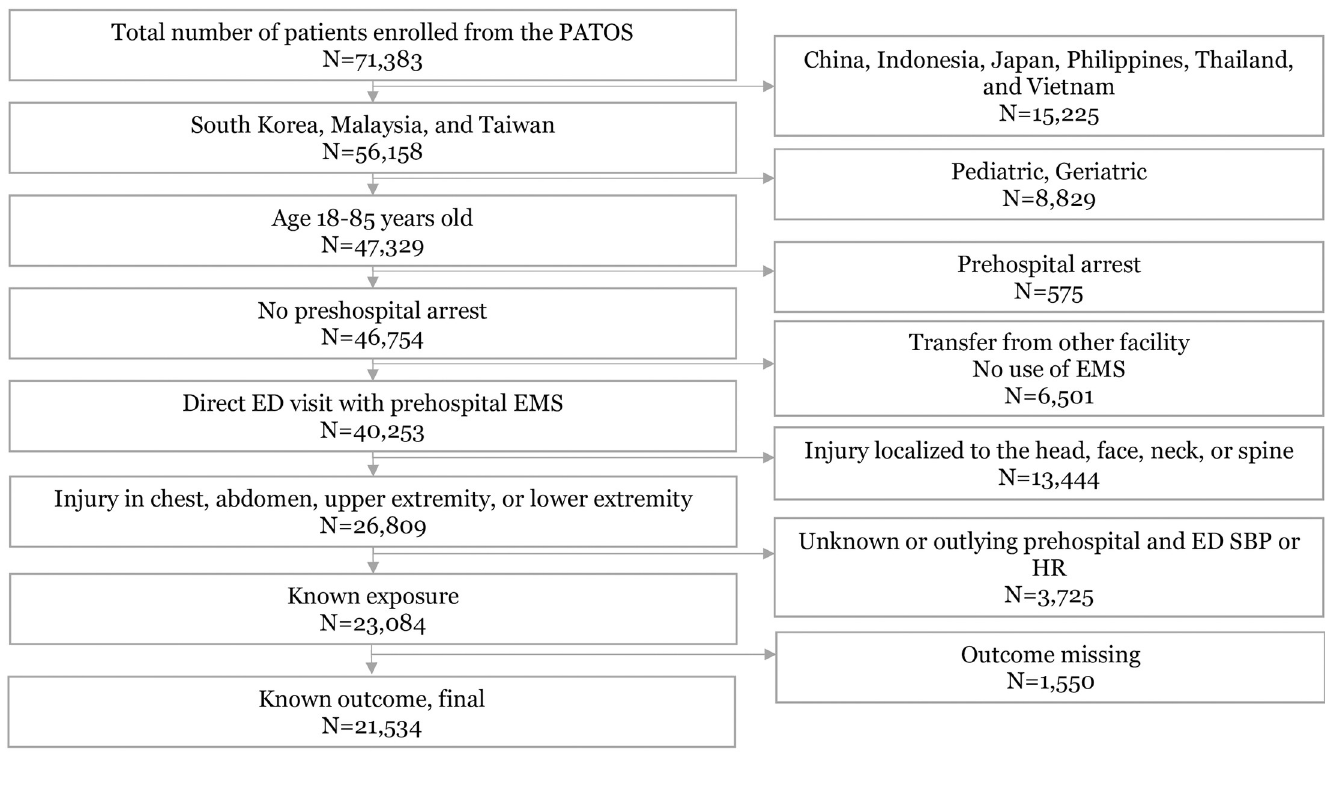
Fig 1. Study flowchart. Abbreviations: PATOS, Pan-Asian Trauma Outcomes Study; ED, emergency department; EMS, emergency medical services; ISS, Injury Severity Score.